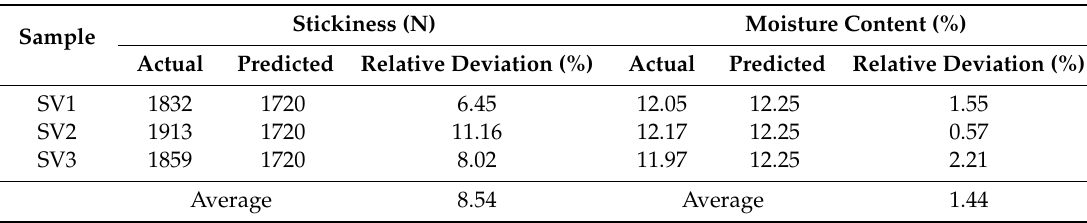
Table 10. Experiment validation.